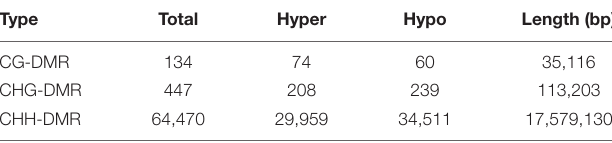
TABLE 2 | Statistics of the number and length of DMRs.